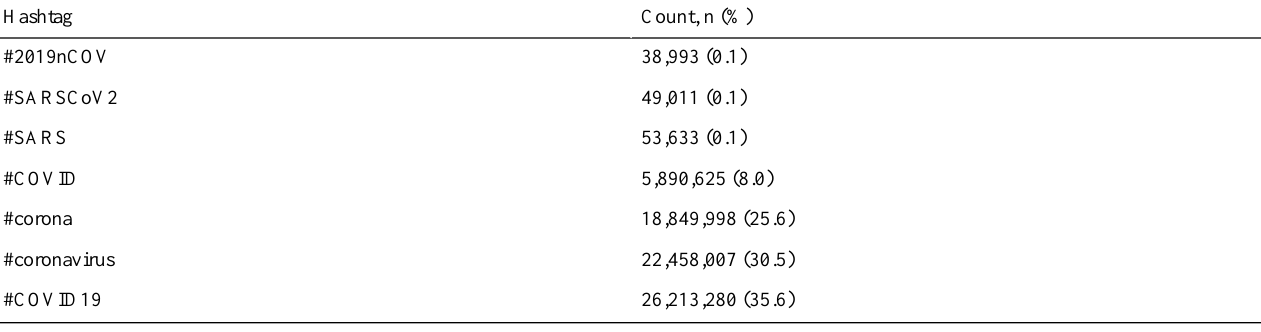
Table 4. Top Instagram hashtags related to coronavirus disease (COVID-19) scientific and infodemic